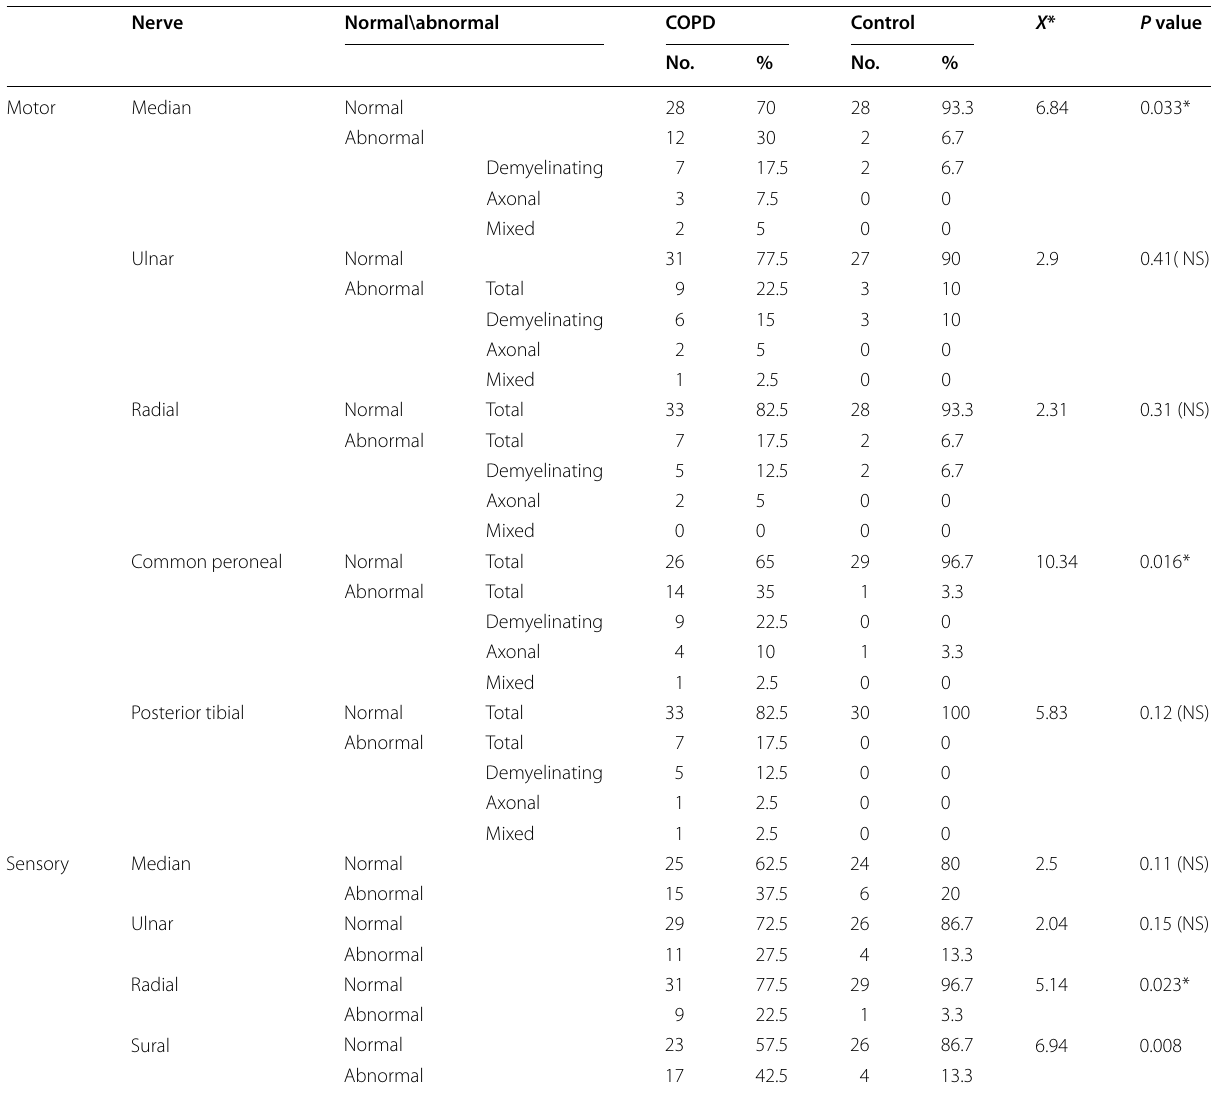
NS non‑significant